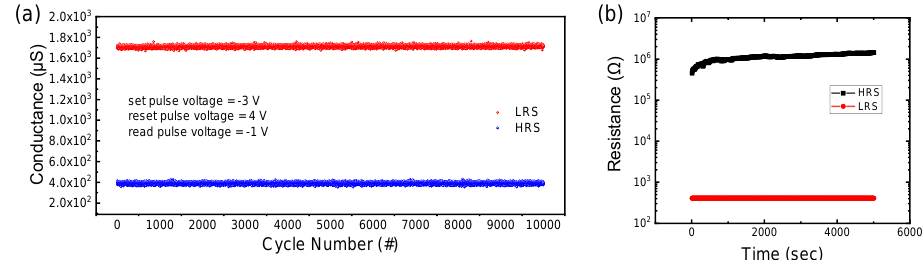
Figure 5. ( a ) Pulse endurance and ( b ) and retention properties of the Pt/SiO X /TaN RRAM